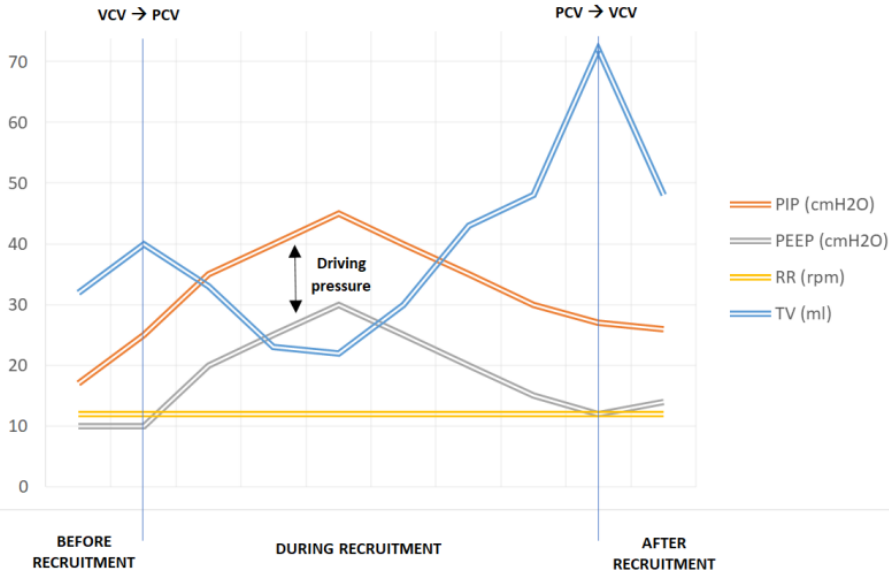
Figure 5. Lung mechanics parameters during RMs. PIP: peak inspiratory pressure; PEEP: positive end-expiratory pressure; RR: respiratory rate; TV: tidal volume; VCV: volume-controlled ventilation; PCV: pressure-controlled ventilation.